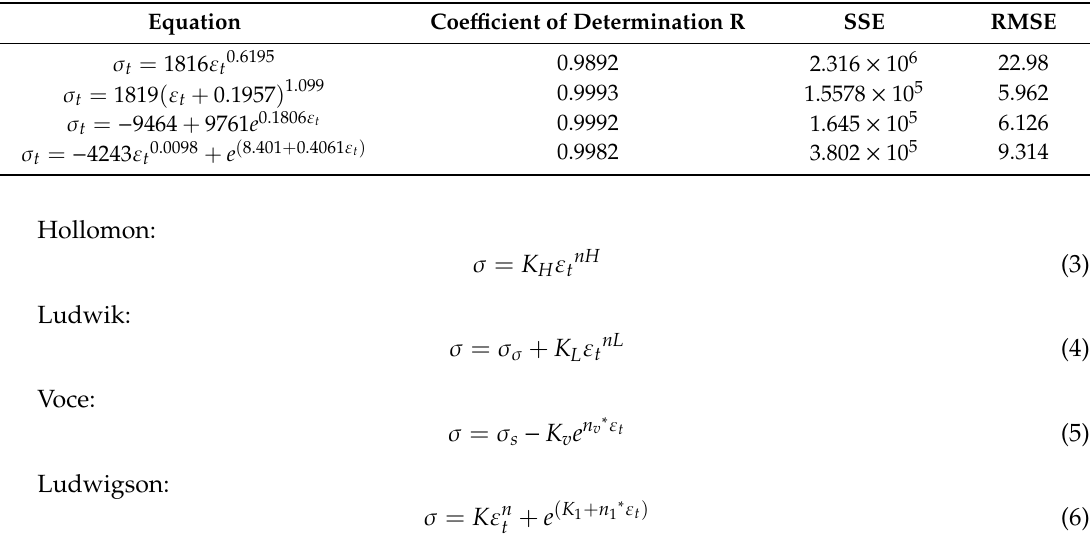
Table 1. Fitting equation of the stress–strain curve of the superalloy GH1140. Equation